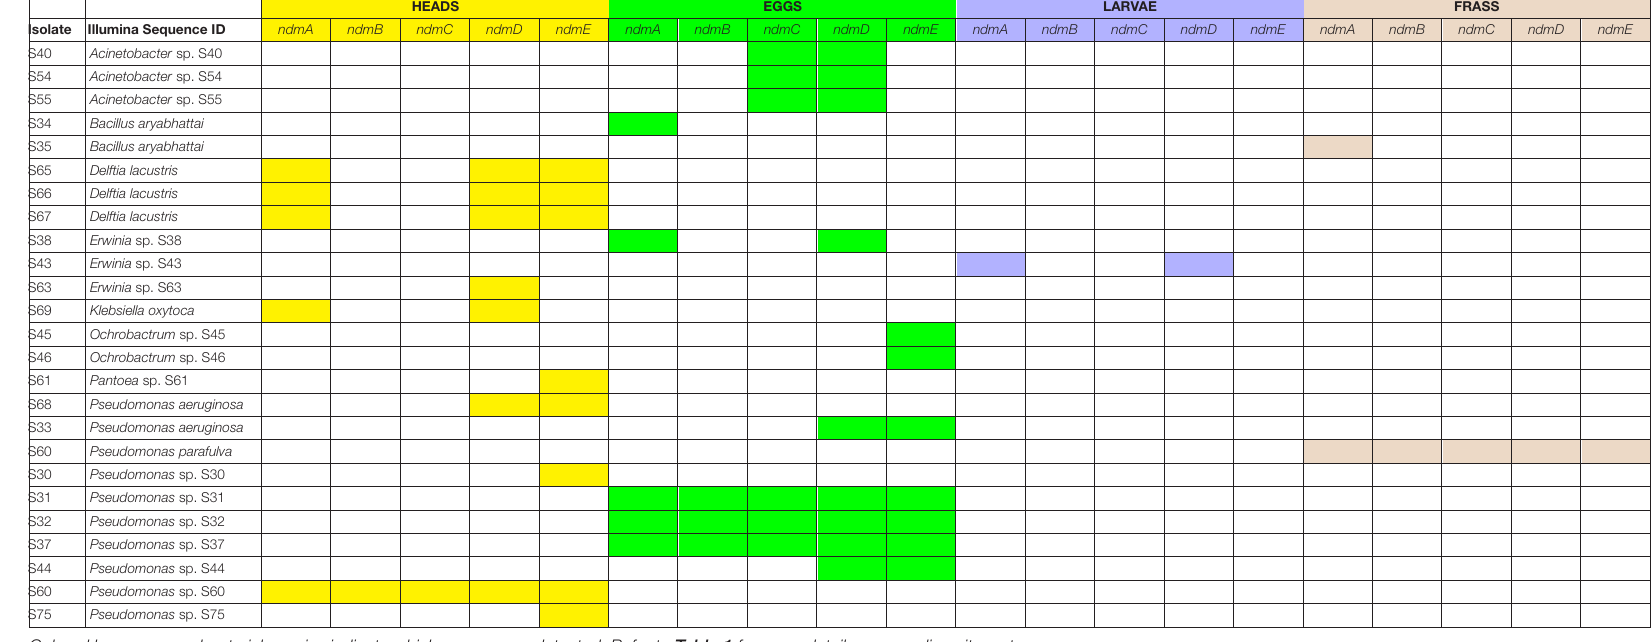
Colored boxes across bacterial species indicate which genes were detected. Refer to Table 1 for more details on sampling sites,